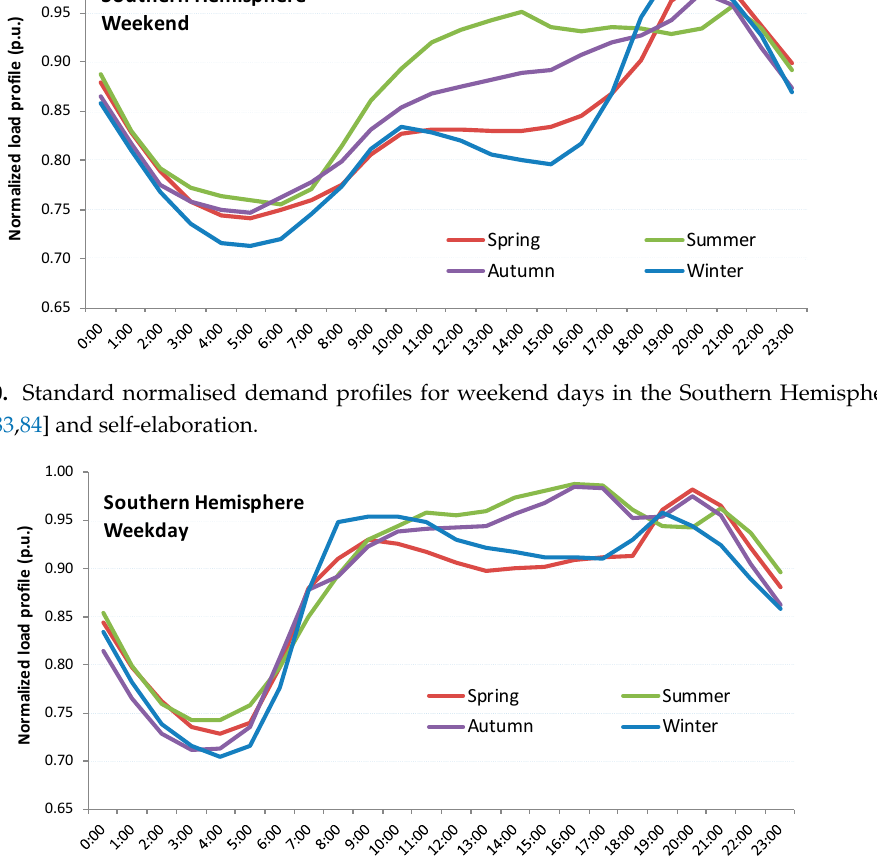
Figure 11. Standard normalised demand profiles for weekdays in the Southern Hemisphere. Source: [83,84] and self-elaboration.